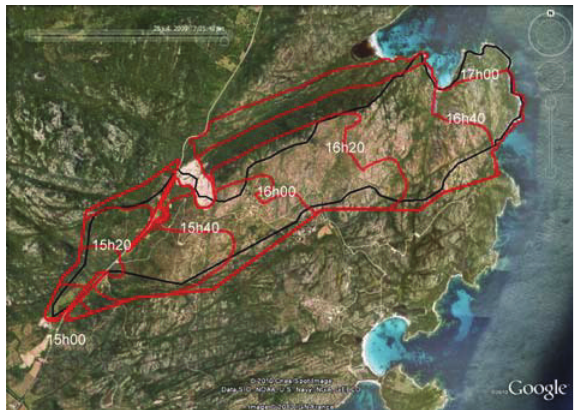
Figure 11: Simulated intermediate fire perimeters obtained with a non constant wind and Anderson [26] fuel model FM4 for Suartone fire. Observed final perimeter is in